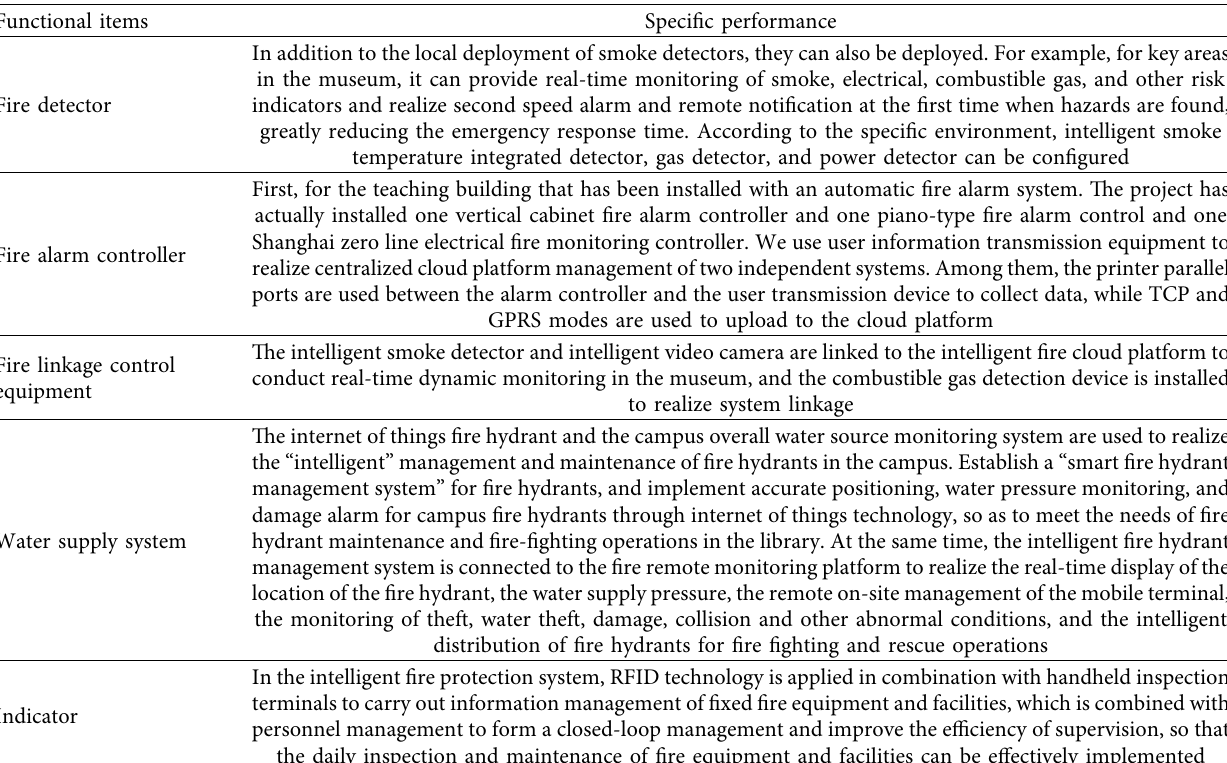
Figure 6: AI fre-fghting facilities management system. Source: Lian technology company. Table 12: Interview feedback of the